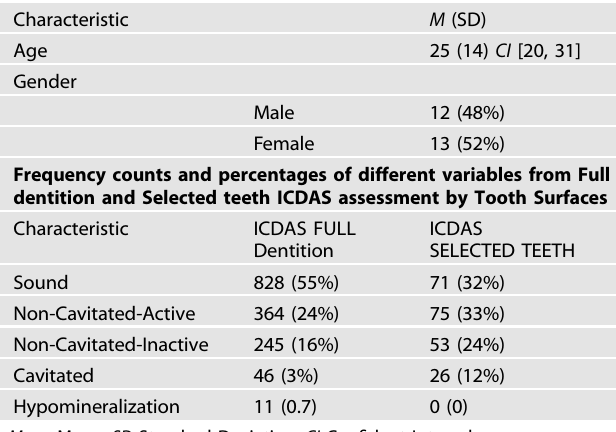
Mean Mean, SD Standard Deviation, CI Con fi dent